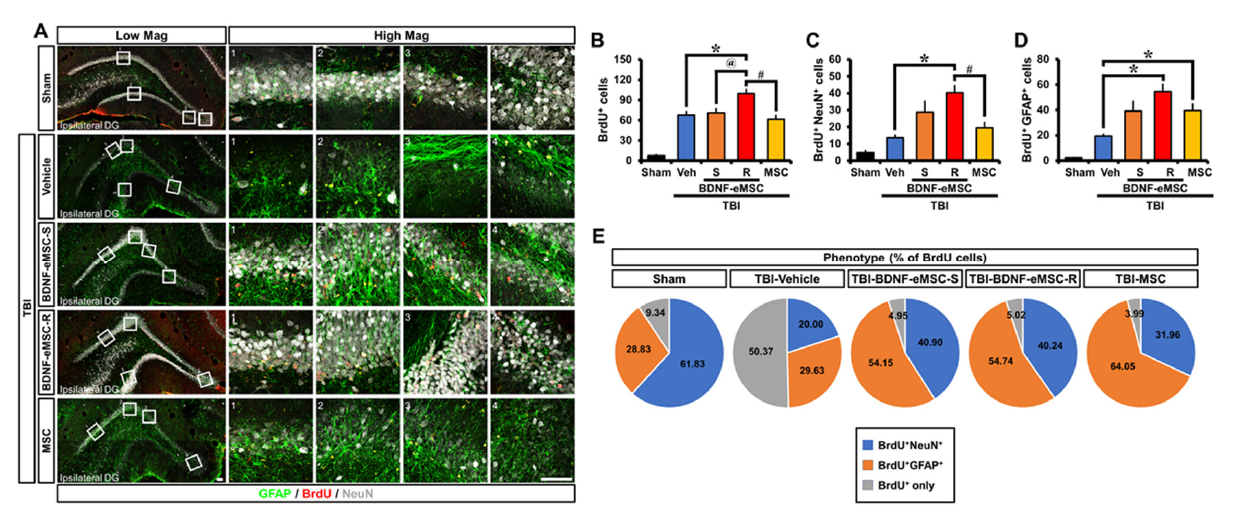
Figure 6. Repeated administration of BDNF-eMSCs increases adult hippocampal neurogenesis and glio- genesis after TBI. ( A ) Representative immunofluorescence images showing the phenotype of cells surviving in the sub-granular zone/granular cell layer (SGZ/GCL). Scale bar, 10 µ m. ( B – D ) Quantification of the number of BrdU + ( B ), BrdU + NeuN + ( C ), or BrdU + GFAP + cells ( D ), as determined in the SGZ/GCL from the ipsilateral dentate gyrus (DG) 56 days post-TBI. Data are mean ± SEM; n = 7–10 per group. * p < 0.05 vs. vehicle-treated group, # p < 0.05 vs. MSC-treated group, @ p < 0.05 vs. single BDNF-eMSC-treated group (Kruskal–Wallis test followed by Bonferroni post hoc test: ( B ): Chi-square = 24.64, df = 4, p <